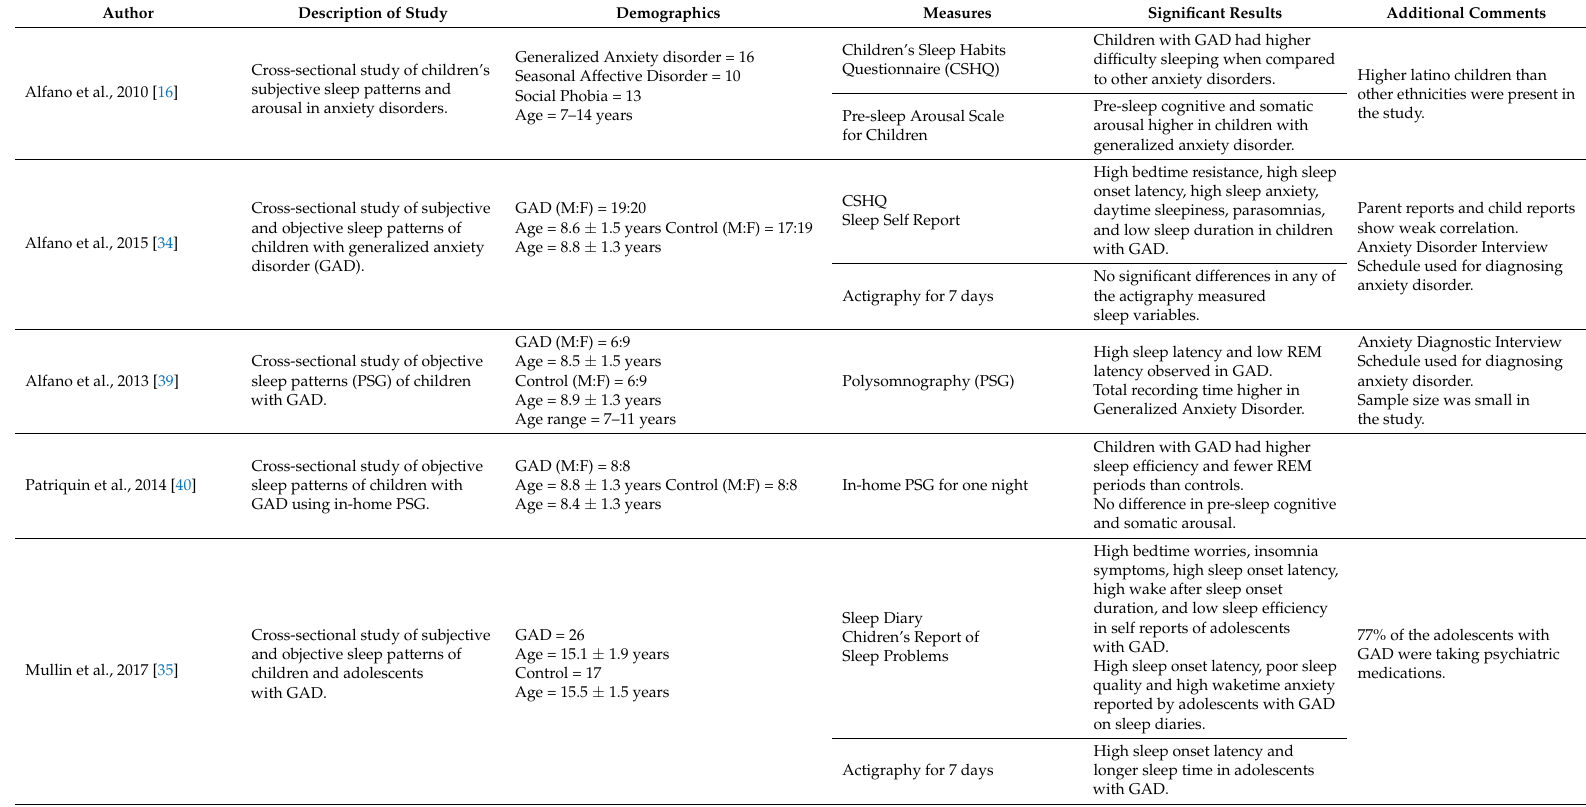
Table A1. Subjective and objective sleep patterns in anxiety and depressive